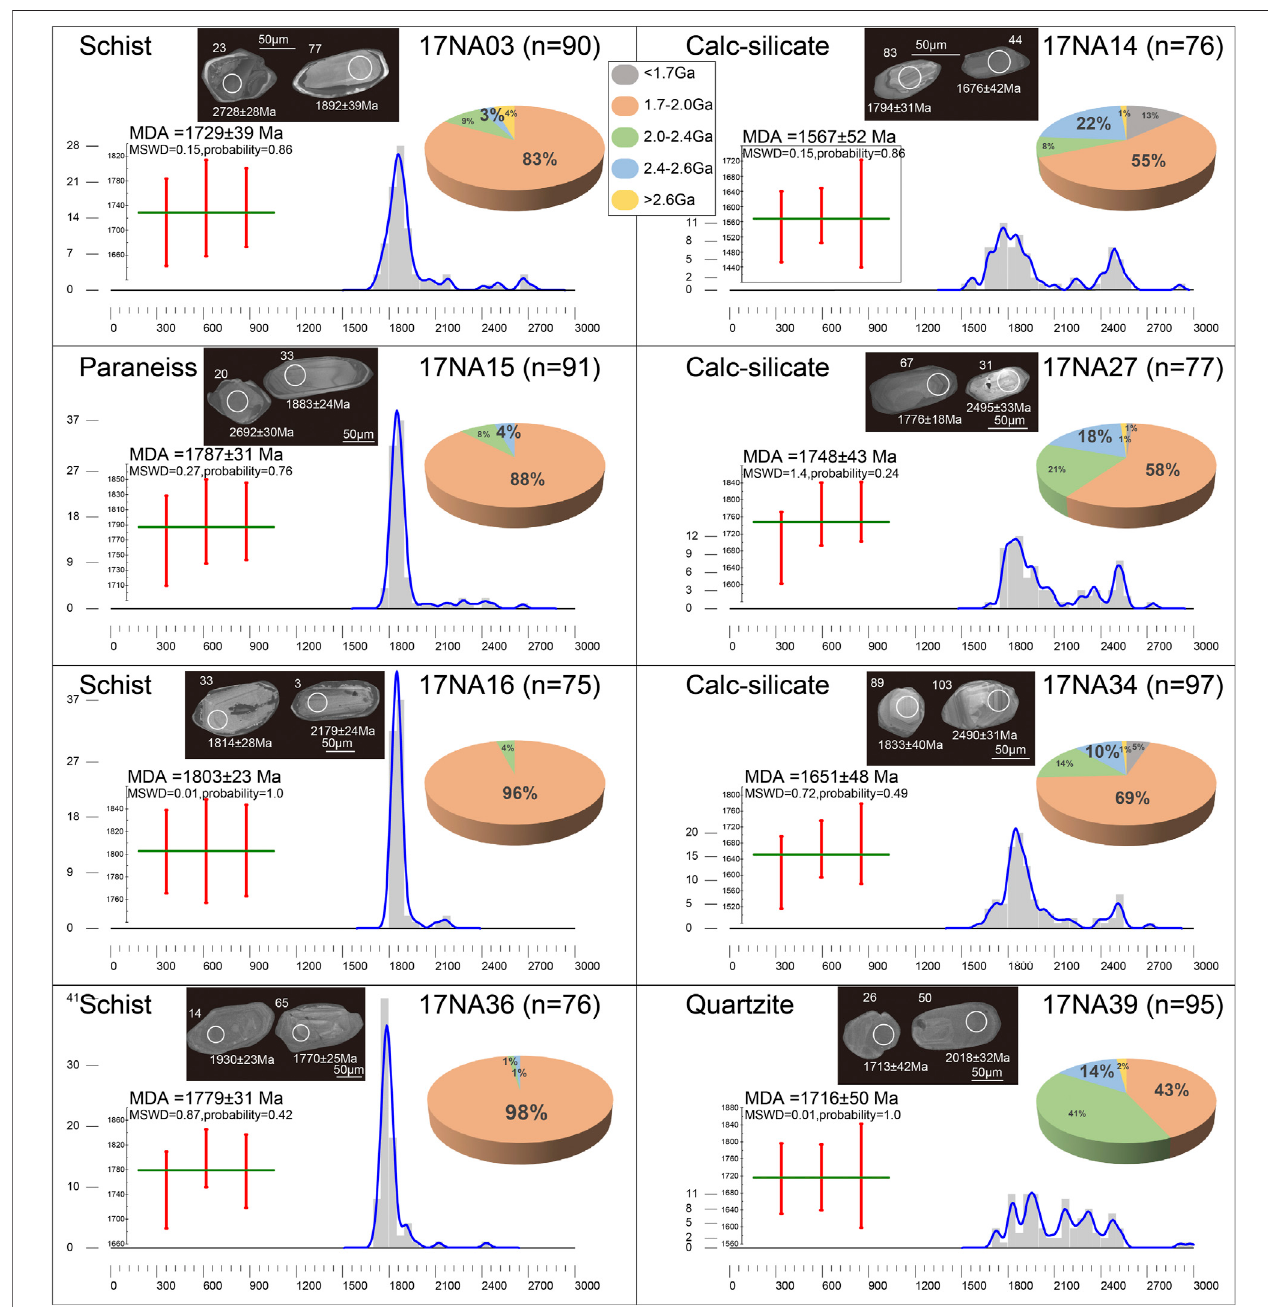
FIGURE 7 | Geochronological data for detrital zircons in metasedimentary rocks. The cathodoluminescent images of the representative zircons in each sample showanalyzedspotslocatedinthecore.Piechartsshowthepercentageoftheageofdifferentage-groups.Themaximumdepositionalage(MDA)isbasedonthemean weighted age of the three youngest zircons in each sample. Kernel density estimation diagrams are based on data of 207 Pb- 206 Pb age with concordance higher than 90%. The left column shows the single peak of spectra, while the right column shows multiple peaks.